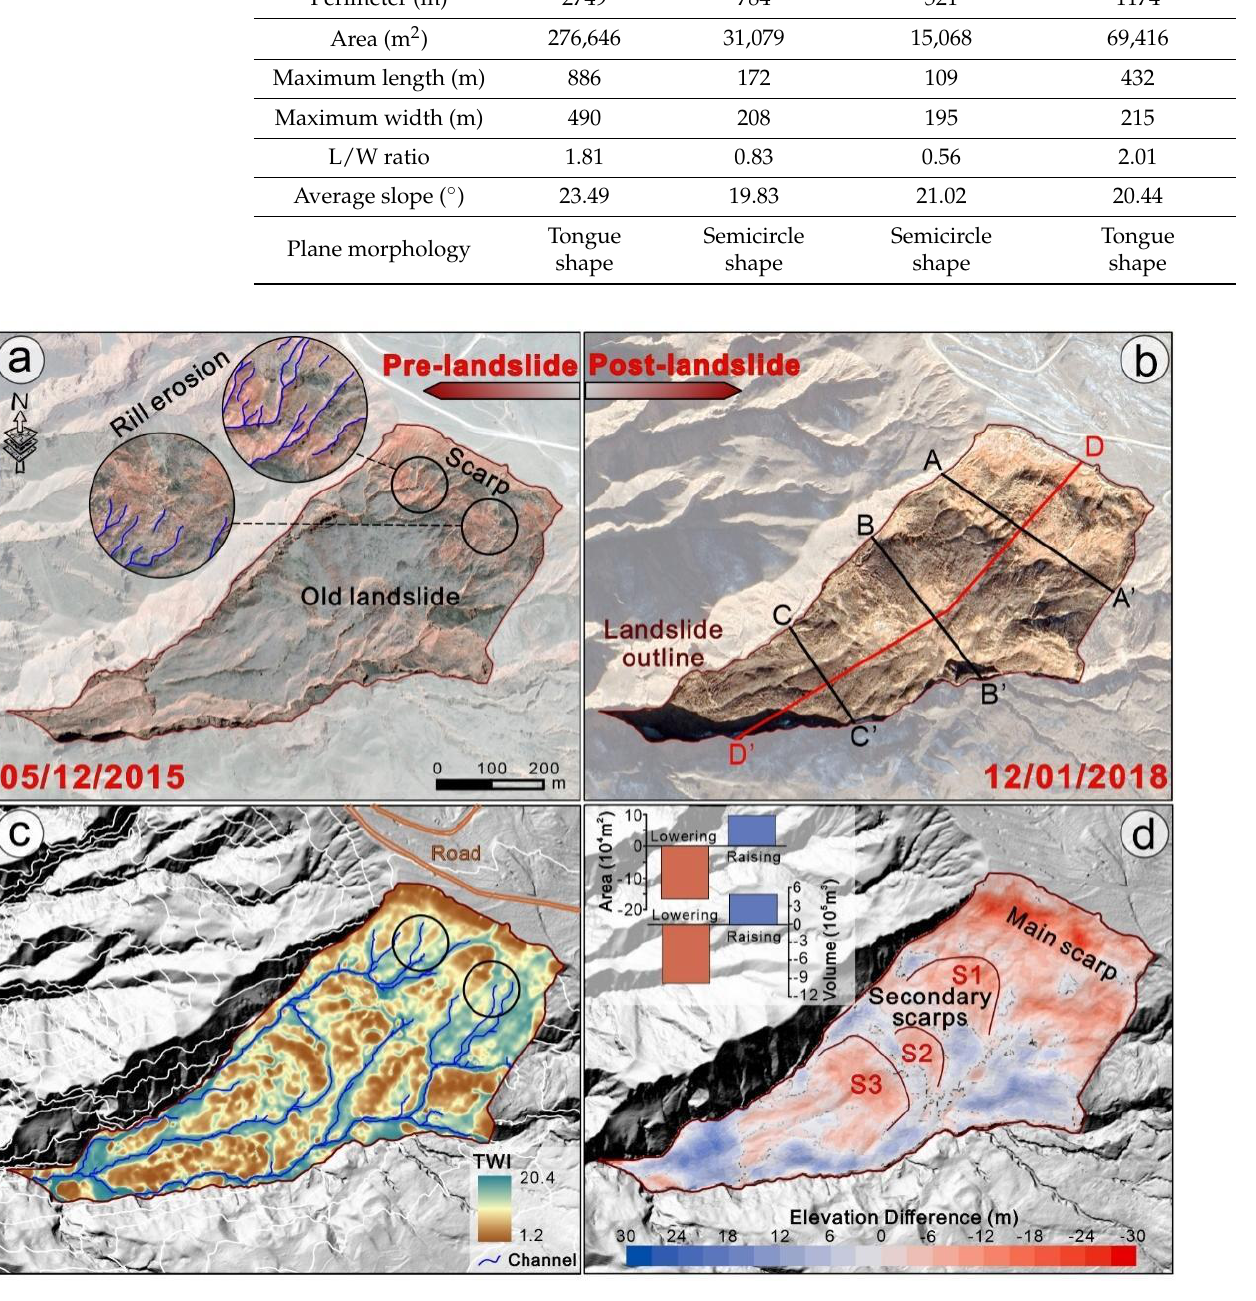
Figure 4. Geomorphological change detection. ( a ) Remote sensing image before landslide. ( b ) Remote sensing image after landslide. ( c ) Topographic wetness index (TWI) and hydrological channels. ( d ) Elevation difference before and after the landslide.